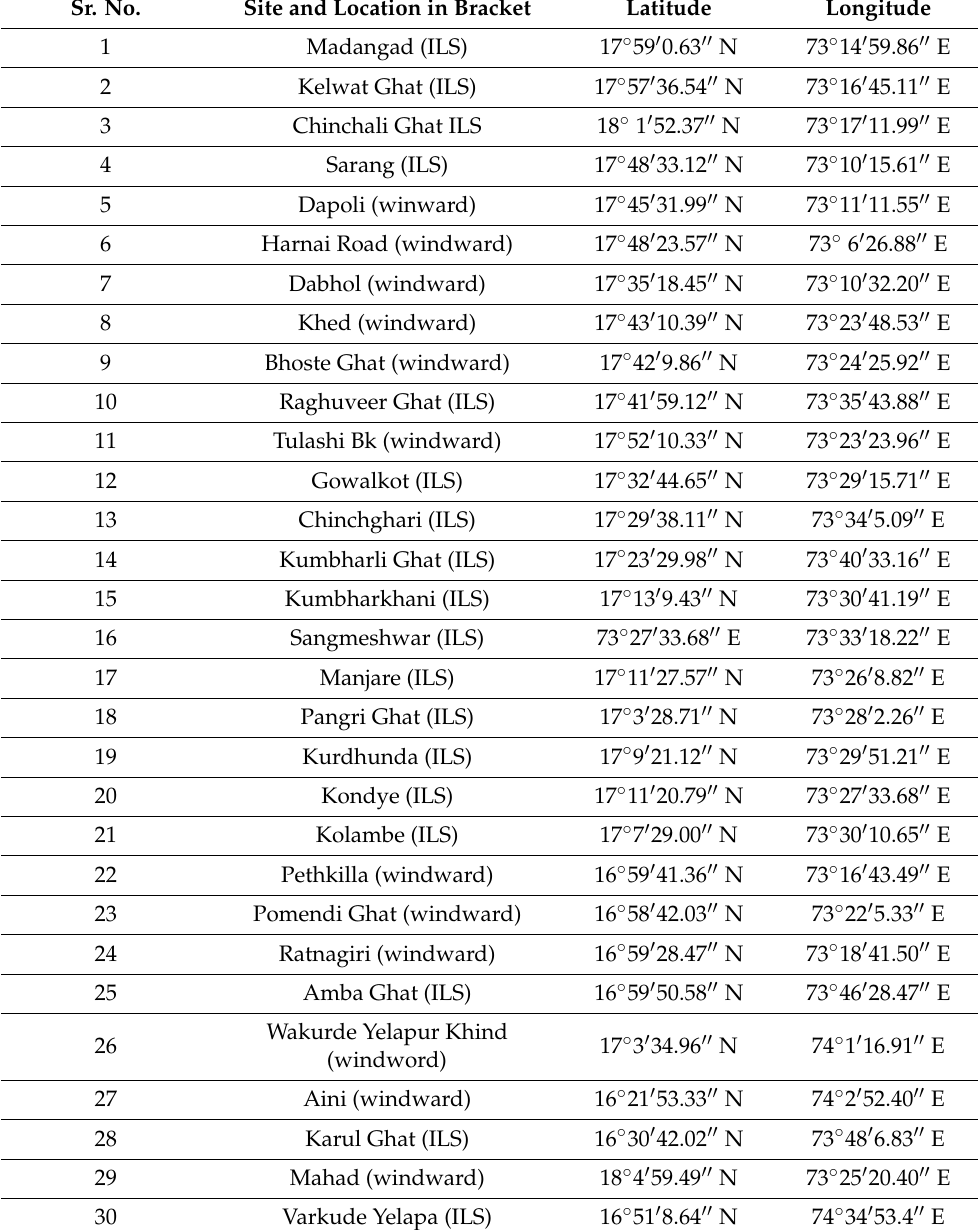
Table 5. Landslide-prone sites: Ratnagiri Kolhapur region. Th e words windward, ILS and DLS indicate the locations of LS sites on the windward, immediate leeward and distant leeward sites, of the WG mountains, respectively.